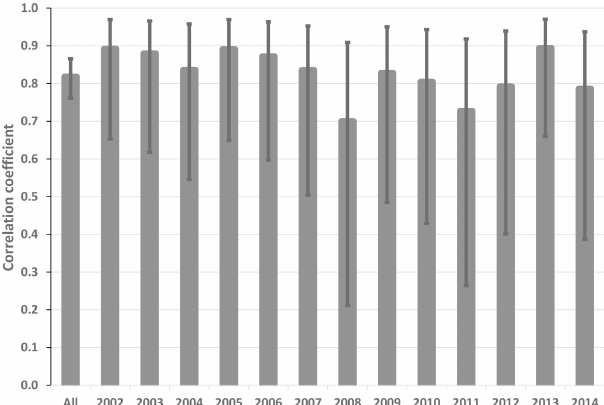
Figure 2. Correlation coefficients with error bars indicating the 95% confidence interval between 12 monthly mean NLDN light- ning flash density and mean convective precipitation from 2002 to 2014 over the model domain. All is the correlation coefficient for all the